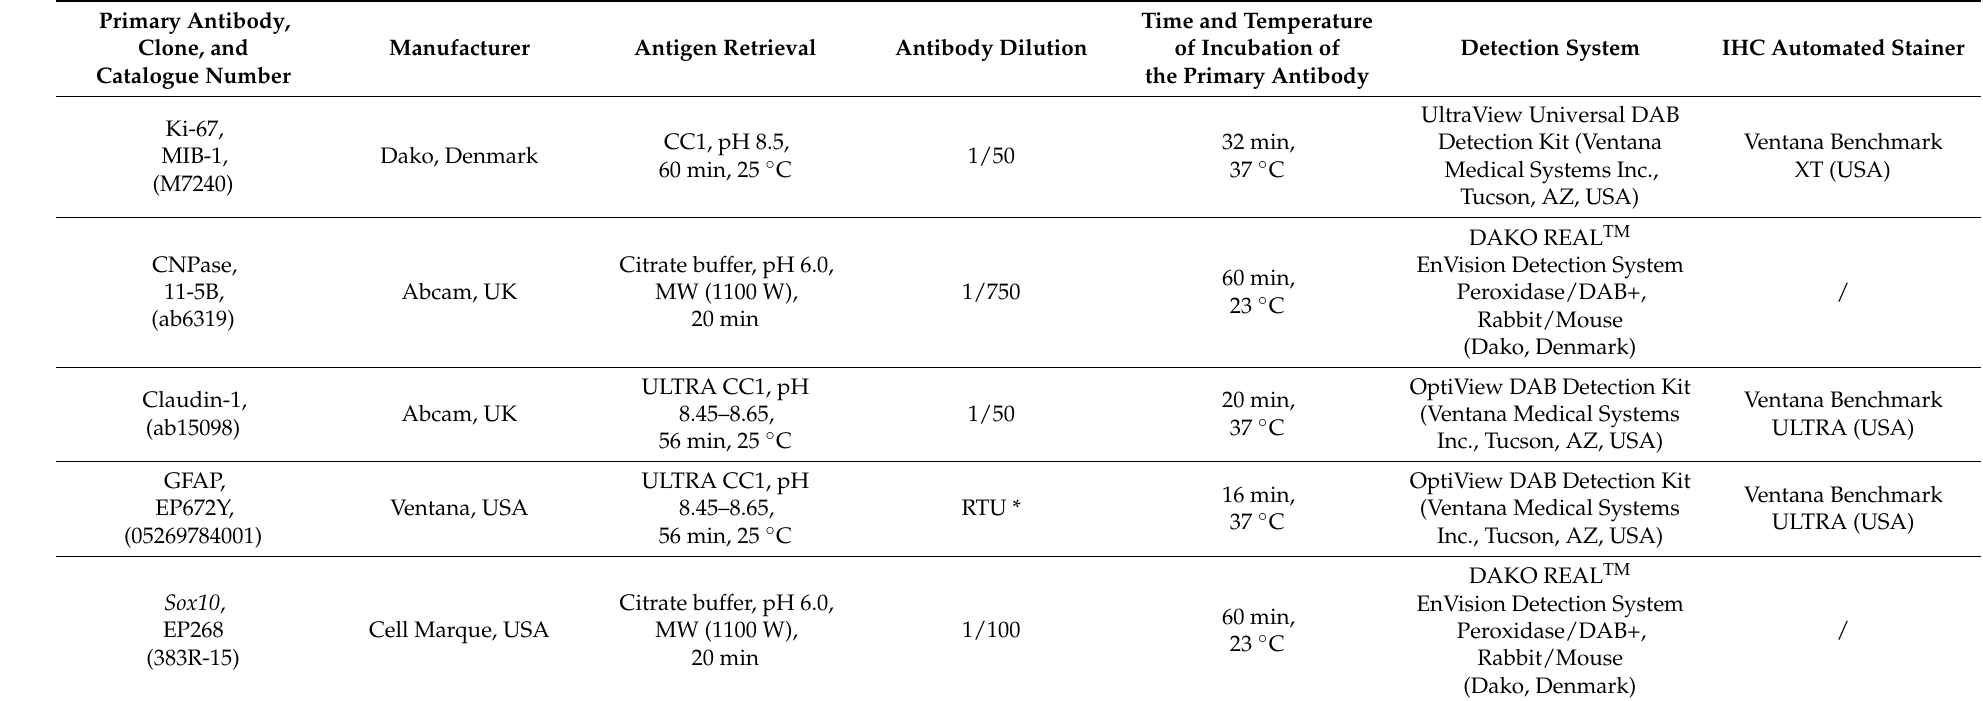
Table 2. Details of the primary antibodies and immunohistochemical